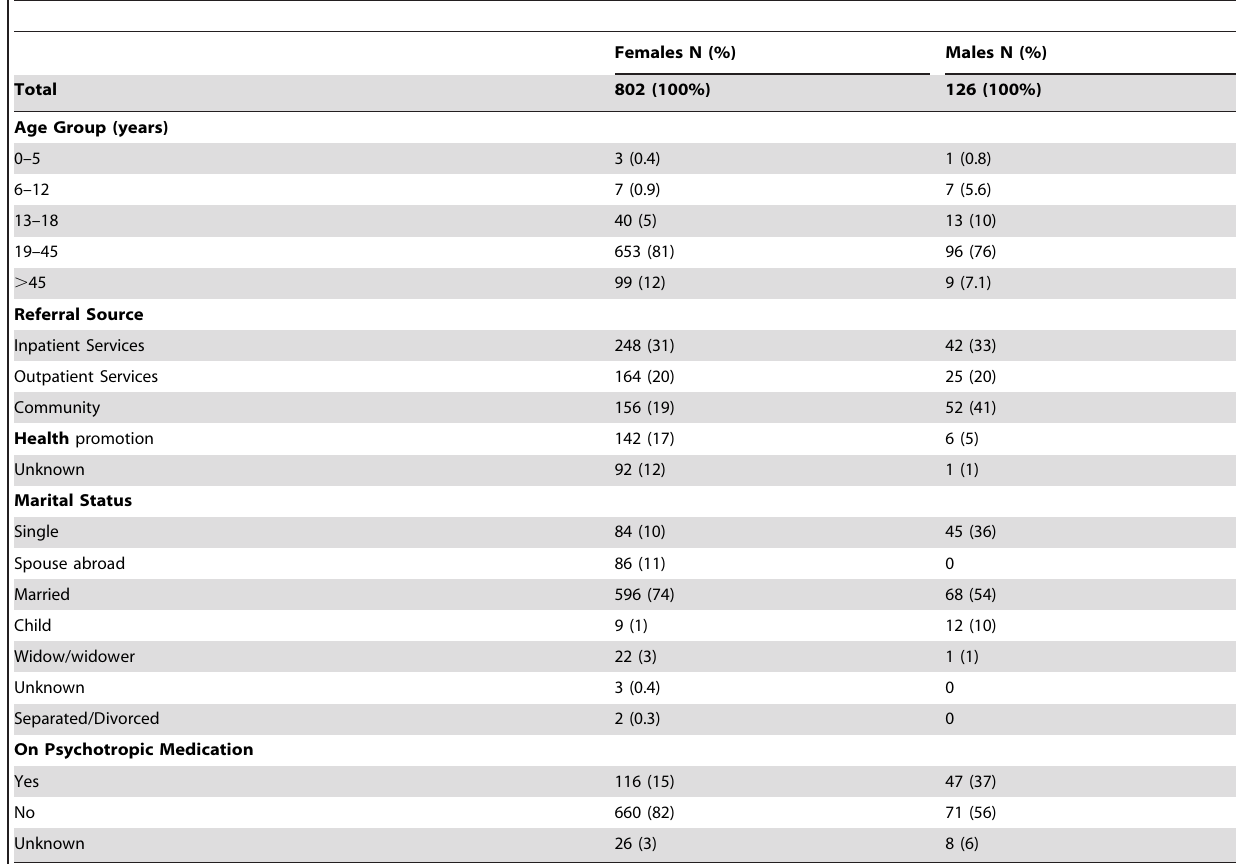
Table 3. Socio-demographic characteristics, source of referral and history of psychotropic medication use stratified by gender, Timurgara district hospital, Pakistan